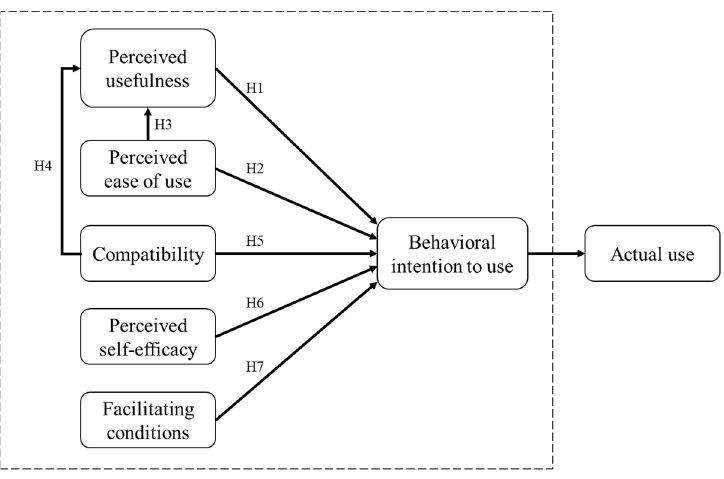
Figure 1. Extended technology acceptance model for LCB acceptance by NCS producers.